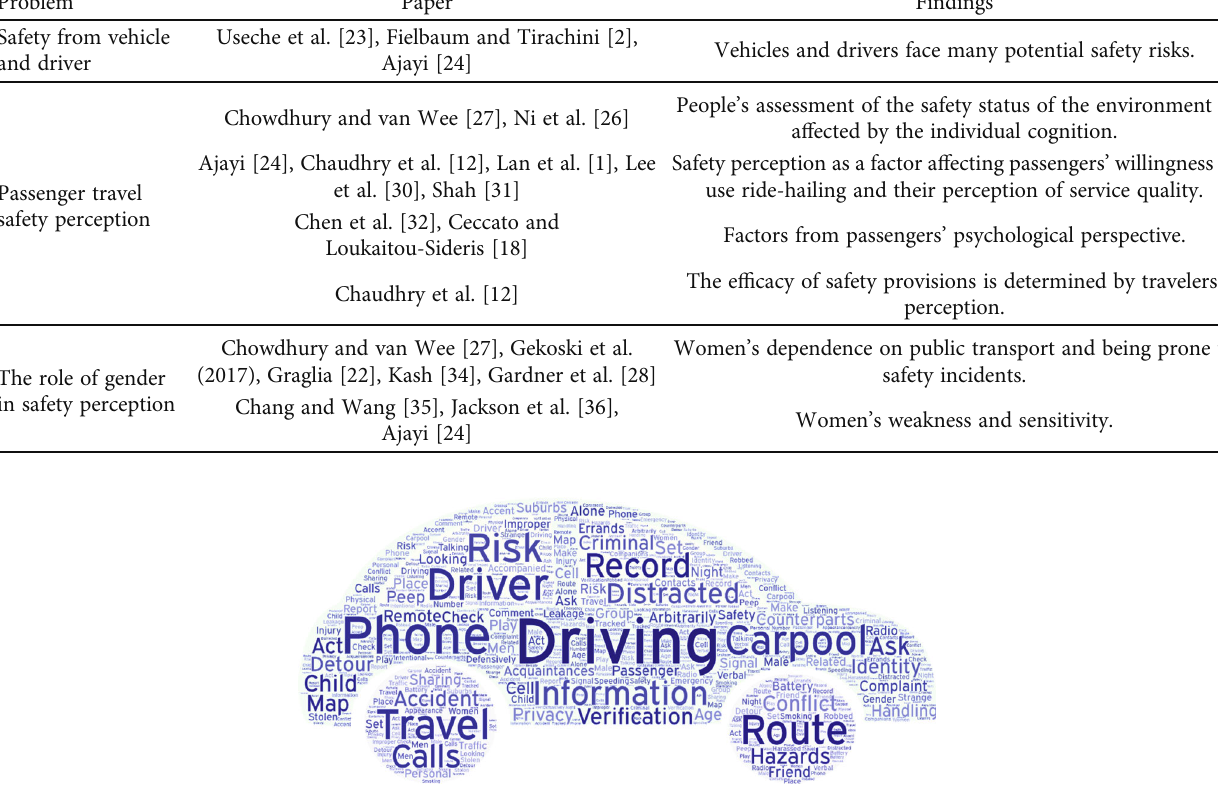
Figure 1: Textural cloud for